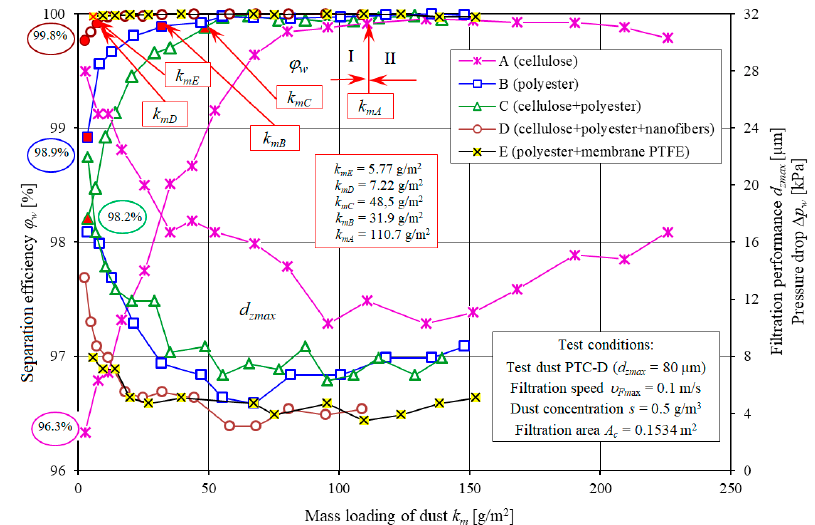
Figure 8. Separation efficiency φ w and filtration performance d zmax as a function of dust mass loading k m of the tested filter elements.